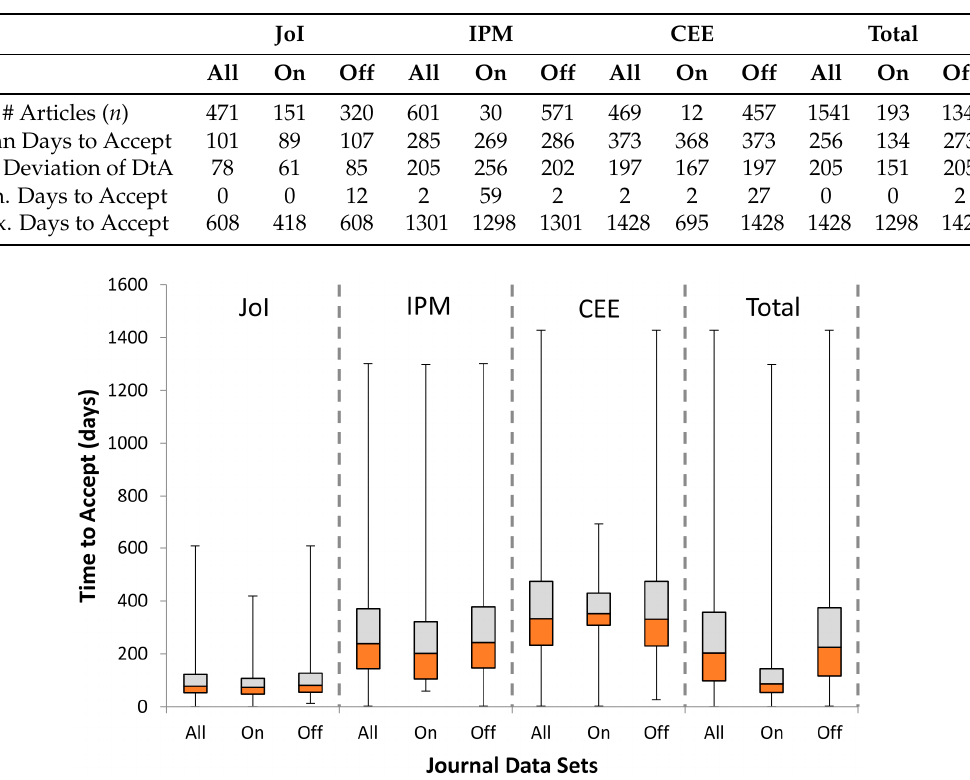
Figure 1. Box plots depicting the statistical properties of our data sets (times to accept of the papers from): Journal of Informetrics (JoI), Information Processing and Management (IPM), Computers and Electrical Engineering (CEE), and their combined aggregate (Total).